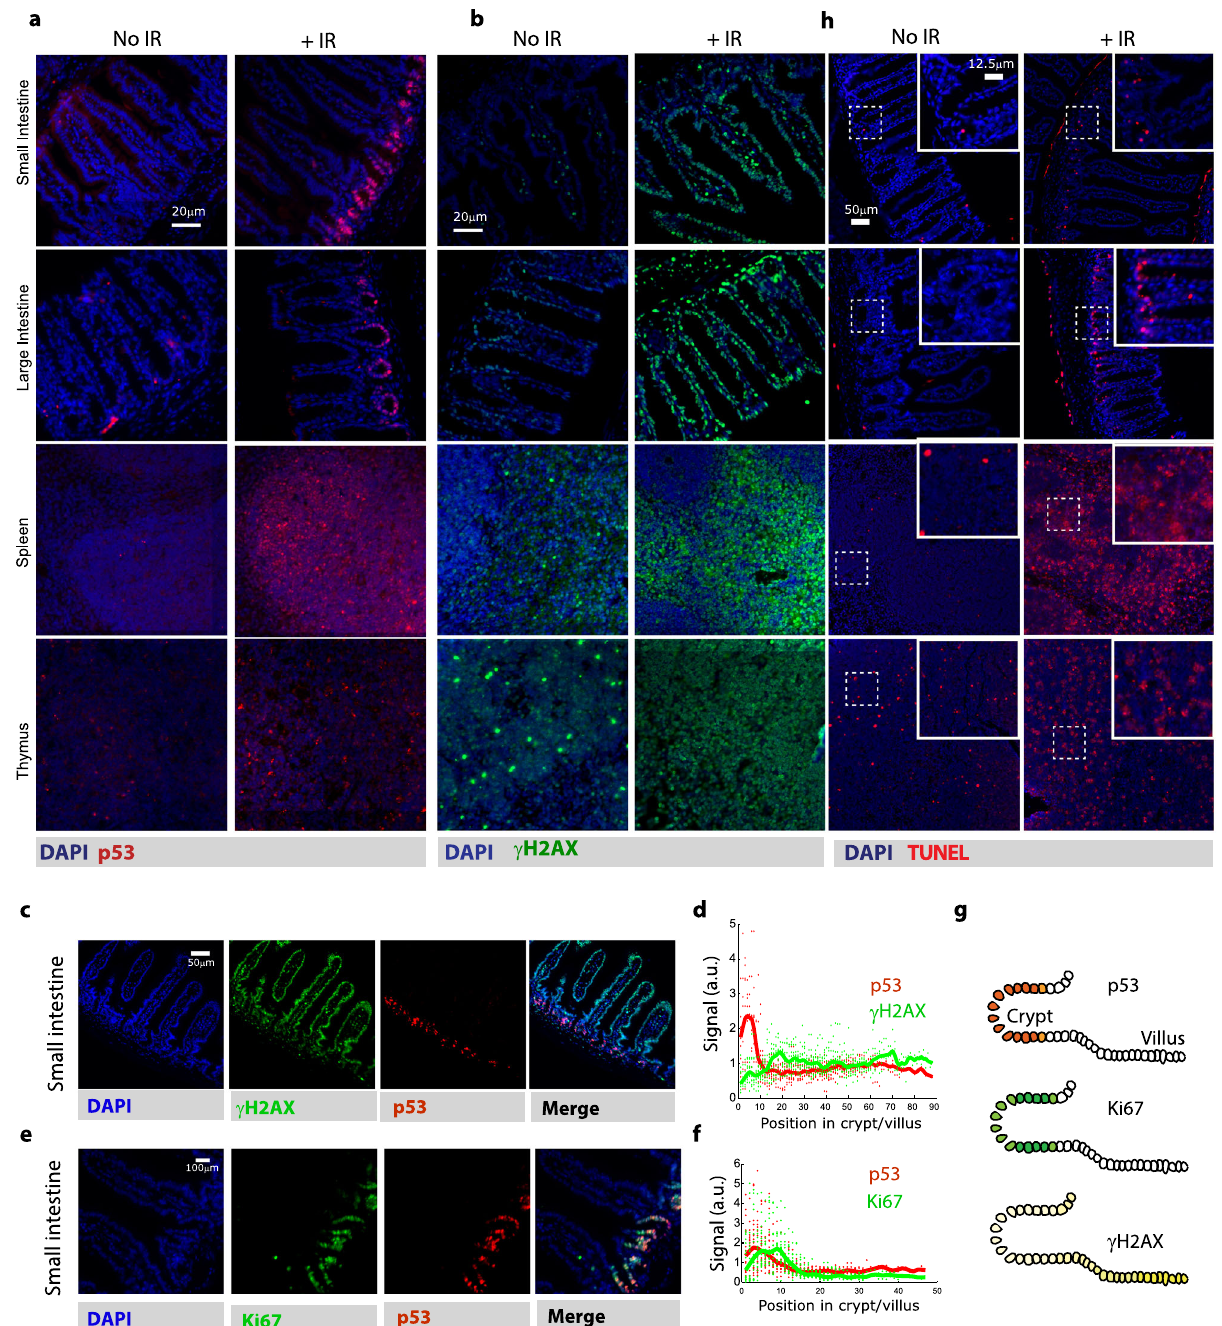
Fig. 1 p53 is induced in irradiated tissues. Mice were subjected or not to total body irradiation (IR) and after 2h the indicated tissues were analyzed by a p53 immuno fl uorescence, b γ -H2AX immuno fl uorescence. Representative images from three ( a ) or two ( b ) independent experiments are shown. c , e Co-staining of p53 and γ -H2AX ( c ) or Ki67 ( e ) in the small intestine 2h after irradiation. d , f Data from c and e , respectively, plotted as a function of cell position from the crypt base. Bold line shows running average; dots represent individual cells ( n = 461 cells ( d ) and 615 cells ( f )). g A diagram of crypt structure and summary of staining results in the small intestine. h TUNEL staining for indicted tissues in untreated mice or 5h after ionizing radiation. Experiments were performed in